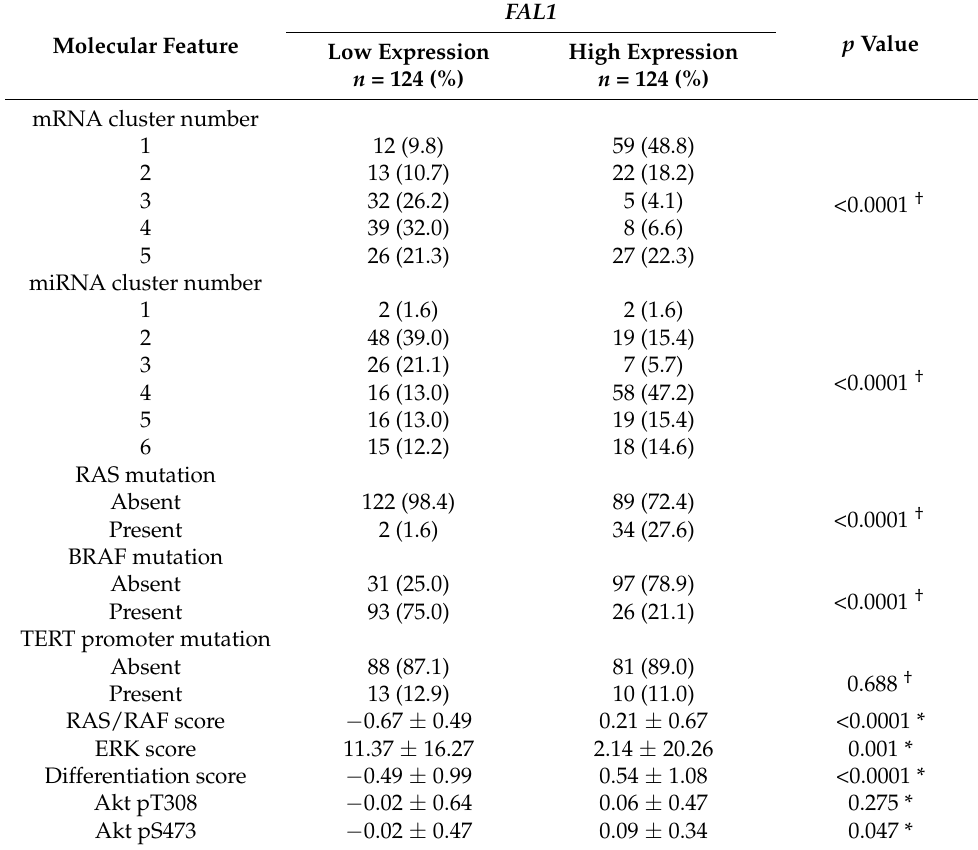
Table 1. Molecular features of TCGA THCA according to FAL1 expression status.